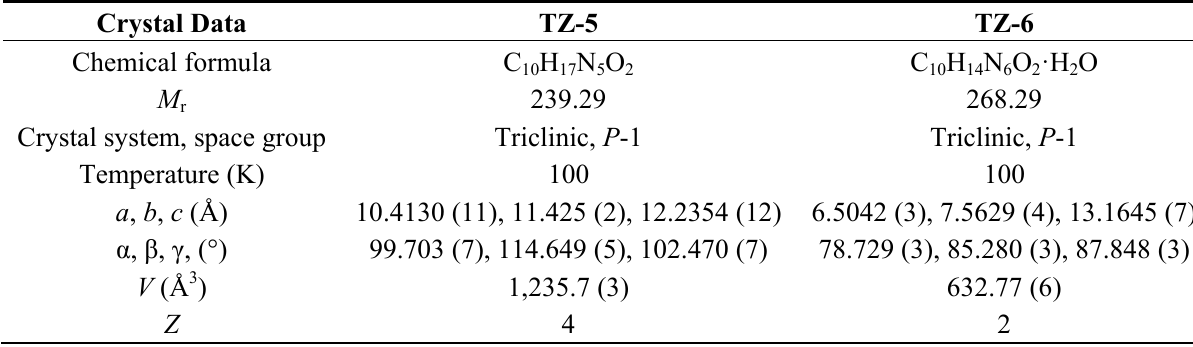
Table 2. Crystal structure parameters for TZ-5 and TZ-6